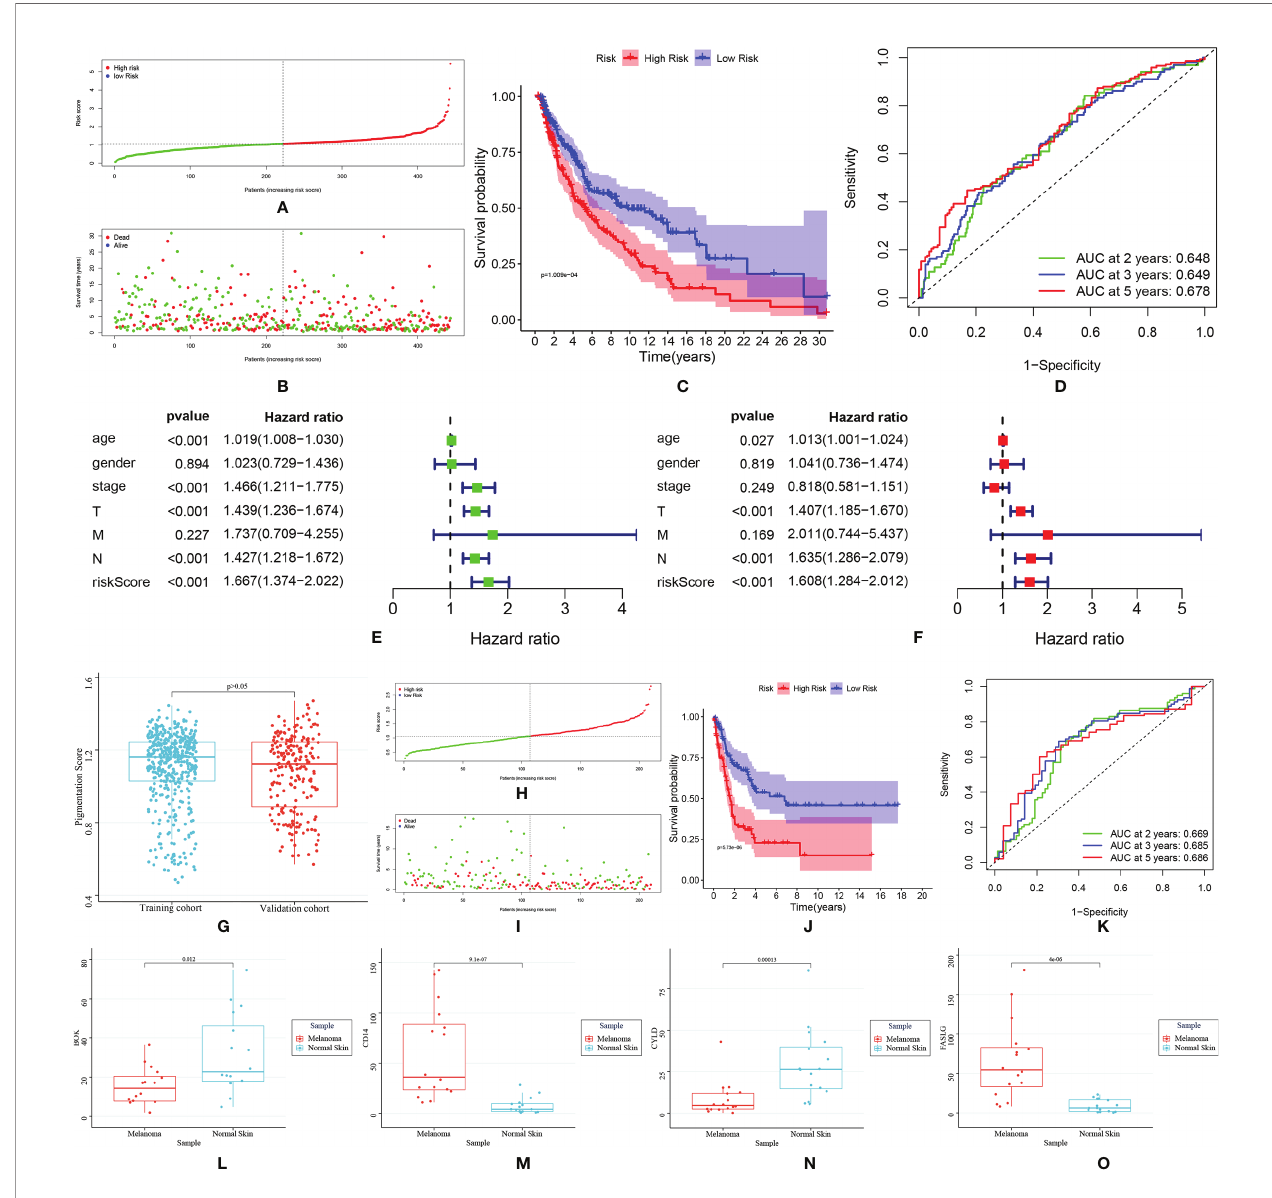
FIGURE 3 | TCGA training cohort: (A) Risk score distribution; (B) Survival status distribution; (C) Kaplan – Meier (KM) curves of overall survival. (D) The ROC curves for 2-, 3-, and 5-year survival; (E, F) Cox regression analysis of risk score and other clinical features [age, stage, gender, stage-T, stage-N, stage-M); (D) The comparison of pigmentation score between training and testing cohort. GEO validation cohort: (H) Risk score distribution; (I) Survival status distribution; (J) Kaplan – Meier (KM) curves of overall survival; (K) ROC curve for 2-, 3-, and 5-year survival. (L – O) ]. The expression of BOK, CD14, CYLD and FASLG in melanoma and normal